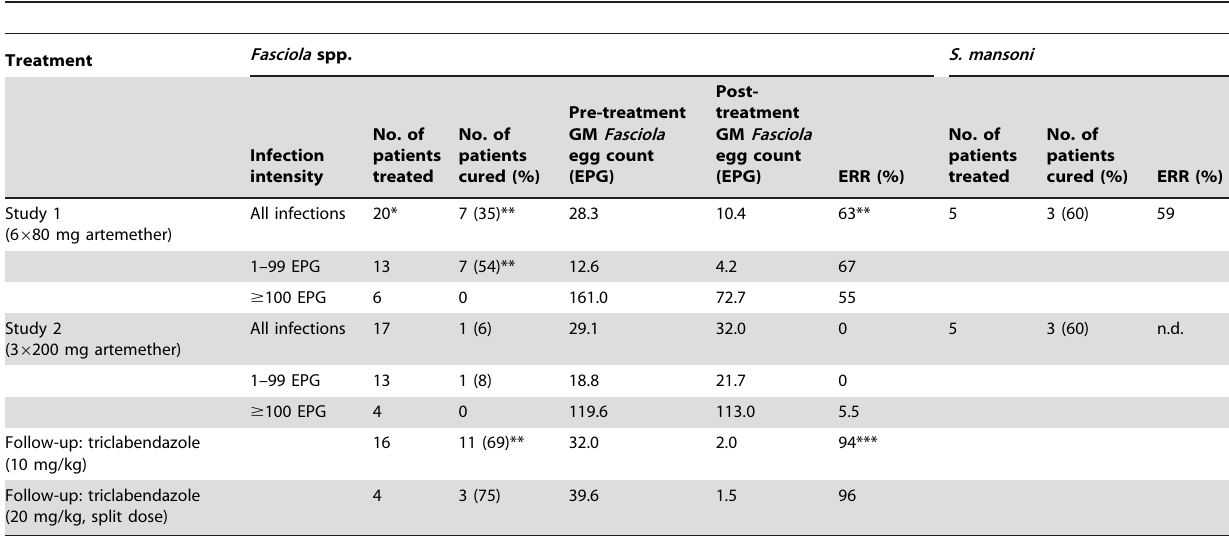
Table 2. Effect of artemether administered at two different regimens to patients infected with Fasciola spp.